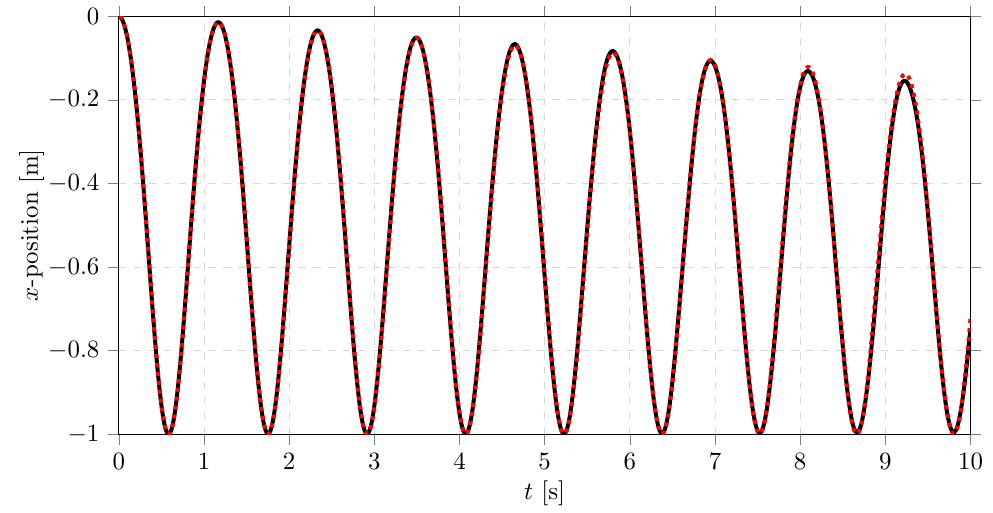
Figure 7: Simulation with complete model in BEAST (black curve) compared with co-simulation using BEAST for each part (red curve) and h TLM = 1 · 10 − 5 s. The curves shows the x -position of the lower arm bearing connection point.